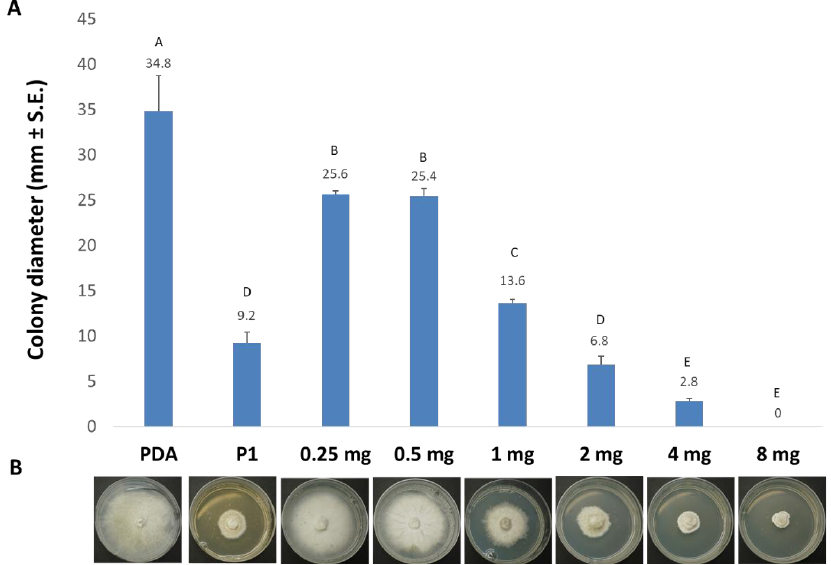
Figure 4. Bioassay of the purified Trichoderma asperellum (P1) active ingredient(s). ( A ) The purified active compound(s) in the growth medium of T. asperellum that inhibit M. maydis growth (described in Figure 3) were embedded in PDA at the